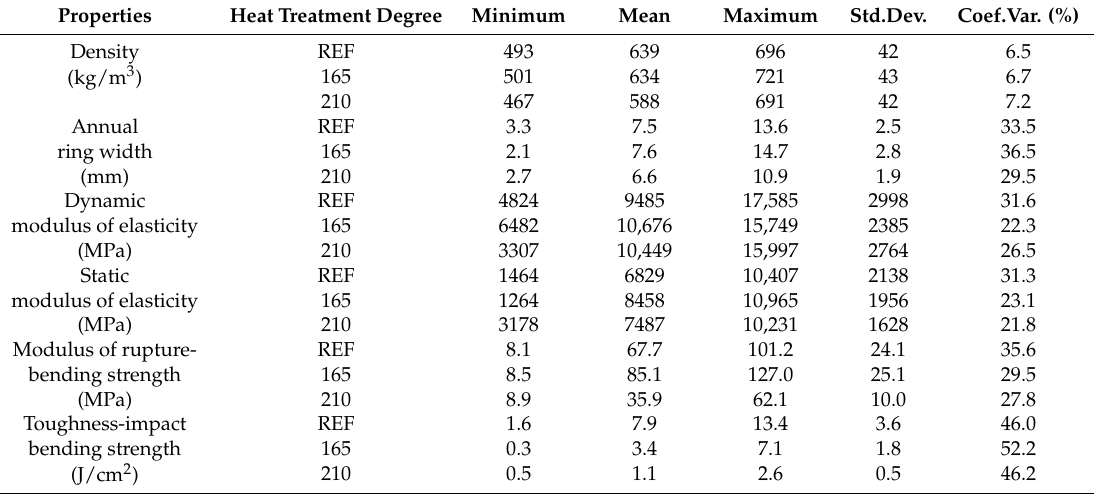
Table 4. Basic Statistical Analyses of the Properties for Untreated and Heat-Treated Birch